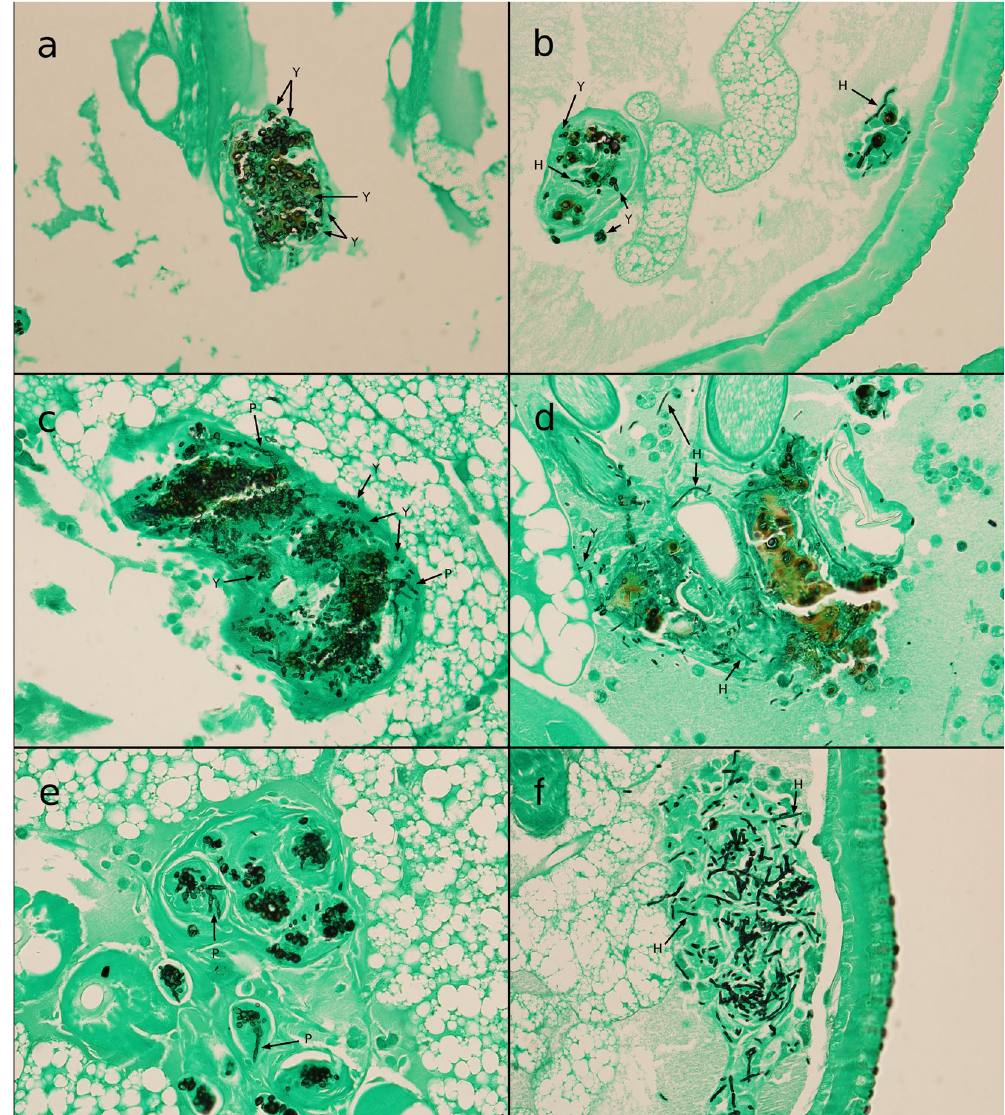
Figure 8. Histopathological analysis of E. dermatitidis in G. mellonella and comparison between a CF strain and a P strain infection. Shown is a typical strain from a cystic fibrosis (CF) patient with no real hyphal structures within the first 72 h after infection; pseudohyphal structures begin to develop within 48 h ( a ) 24 h after infection; ( c ) 48 h after infection; ( e ) 72 h after infection). A strain from an Asian patient (P) with a systemic infection shows the growth of true hyphal structures within 24 h after infection and a massive invasion of hyphae over a period of 72 h ( b . 24 h after infection; ( d) 48 h after infection; ( f ) 72 h after infection). All strains were observed with a light microscope at a magnification of 400x. Slides for histologic analysis were stained with Grocott silver. (H = Hyphae, P = Pseudohyphae, Y =